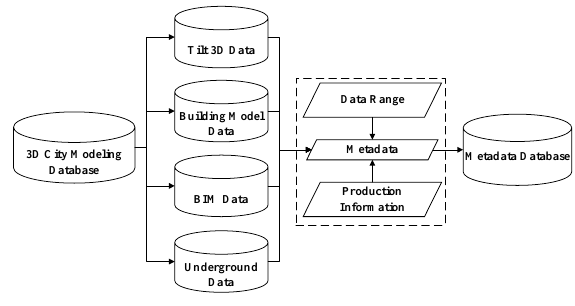
Figure 3 . 3D City Modeling Database and Metadata Database Construction